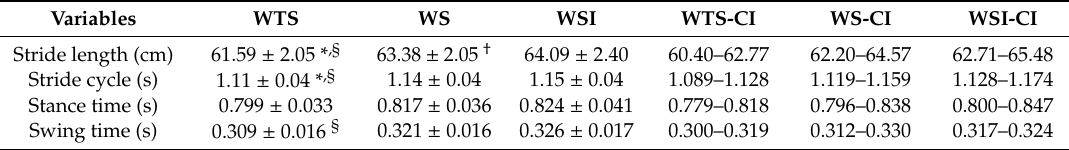
Table 1. Footstep data of the three di ff erent walking conditions.